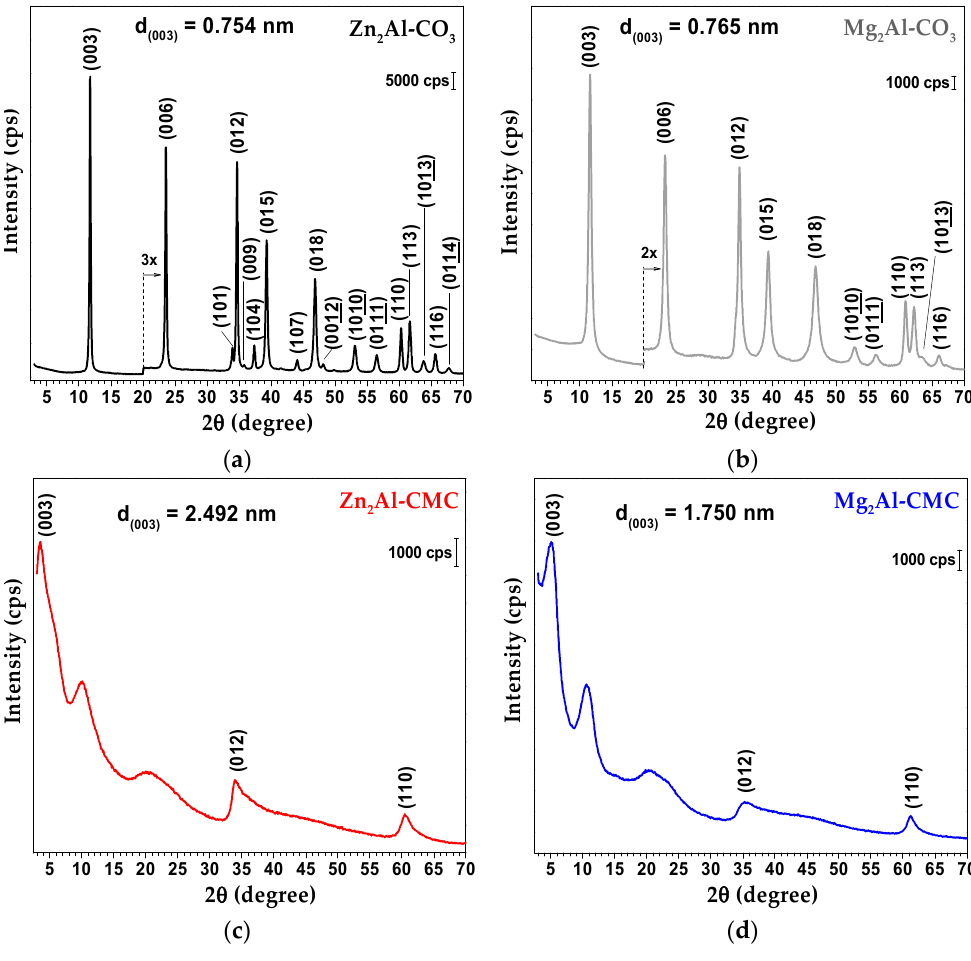
Figure 3. XRD patterns of Zn 2 Al-CO 3 ( a ), Mg 2 Al-CO 3 ( b ), Zn 2 Al-CMC ( c ) and Mg 2 Al-CMC ( d ) samples. The di ff ration peaks in ( a , b ) were indexed according to ICSD 190041 and 86655, respectively .